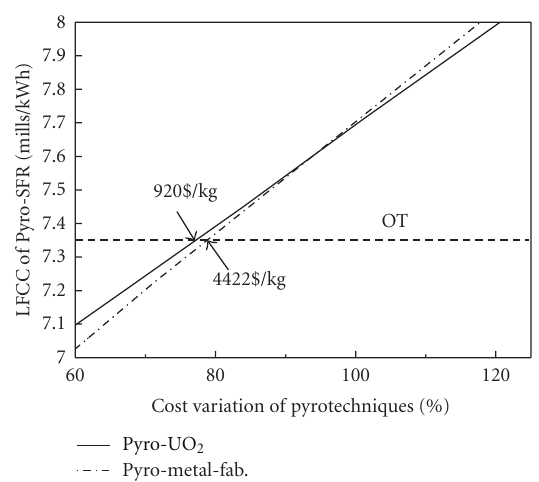
Figure 9: LFCC of Pyro-SFR dependent on the cost of pyrotech-